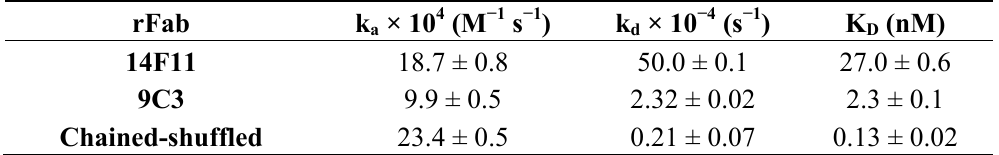
Table 2. Rate and equilibrium dissociation constants for rFabs binding to ricin ( n =